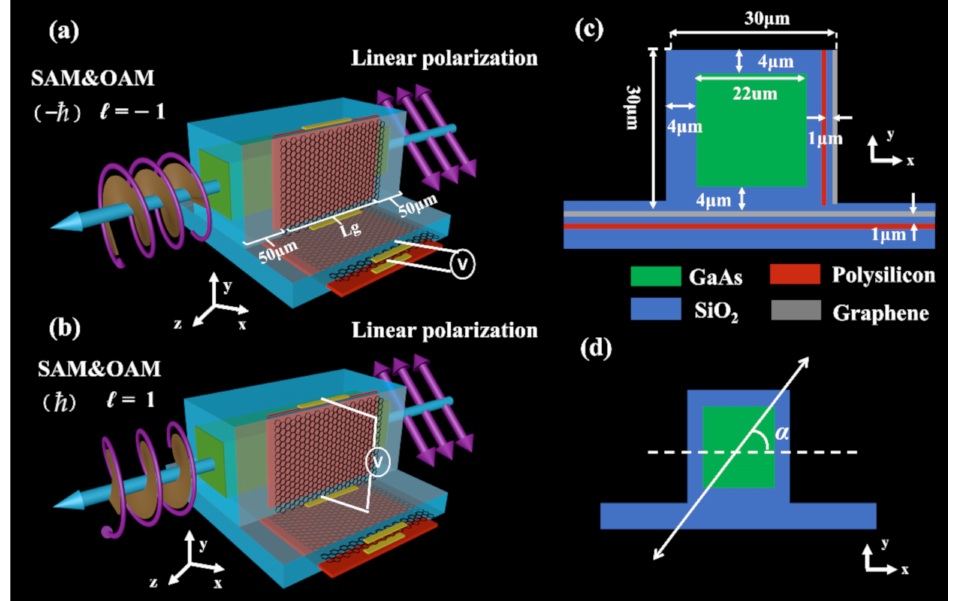
Figure 1. ( a , b ) Schematic of the proposed reconfigurable terahertz (THz) graphene-based hybrid plasmonic waveguide (GHPW) for manipulating angular momentums of guided mode. The linearly polarized light with a polarization angle α = 45 ◦ can be converted into the output beam with spin angular momentum (SAM) = − ¯ h and orbital angular momentum (OAM) (cid:96) = − 1 by biasing the bottom graphene capacitor ( a ) and the output beam with SAM = + ¯ h and OAM (cid:96) = + 1 by biasing the sidewall graphene capacitor ( b ); ( c ) cross-section of the GHPW; ( d ) definition of the polarization angle α of a linearly polarized light incidence into the first dielectric waveguide